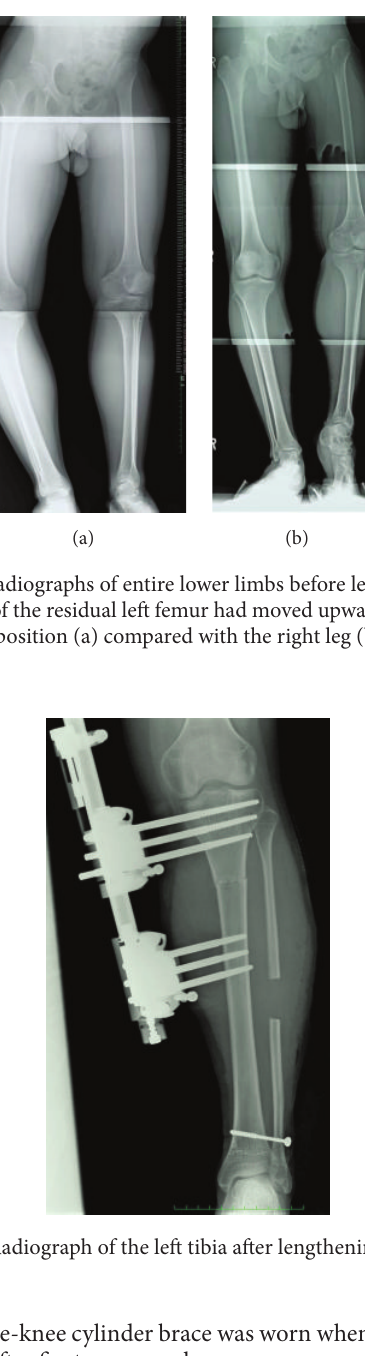
Figure 3: Radiograph of the left tibia after lengthening